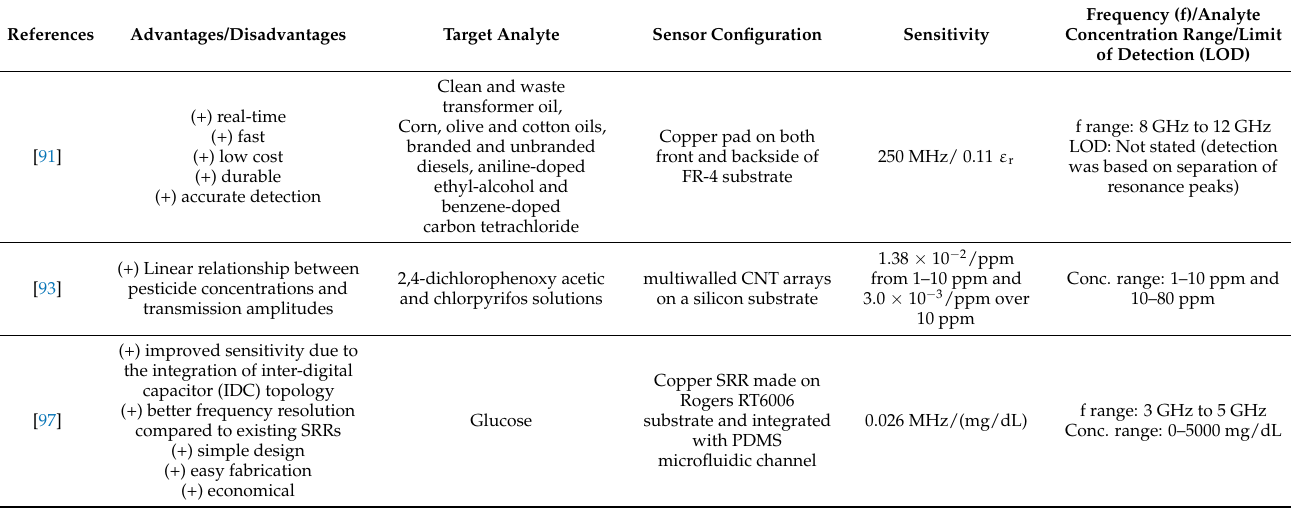
Table 3. Performance comparison of metamaterial-based chemical